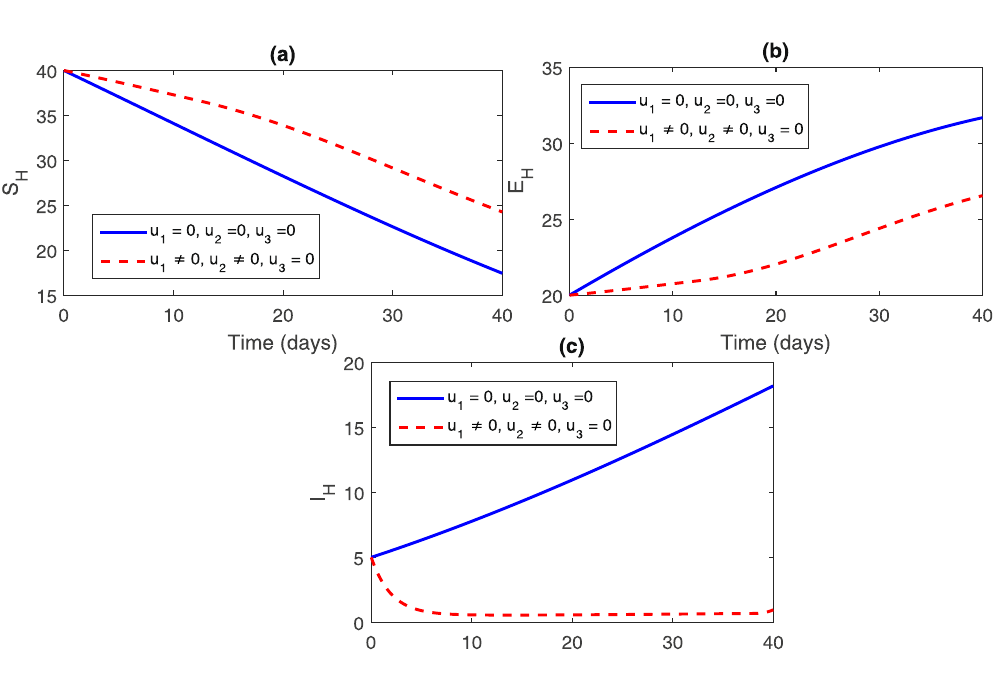
Figure 6. Comparison of both the systems: without and with